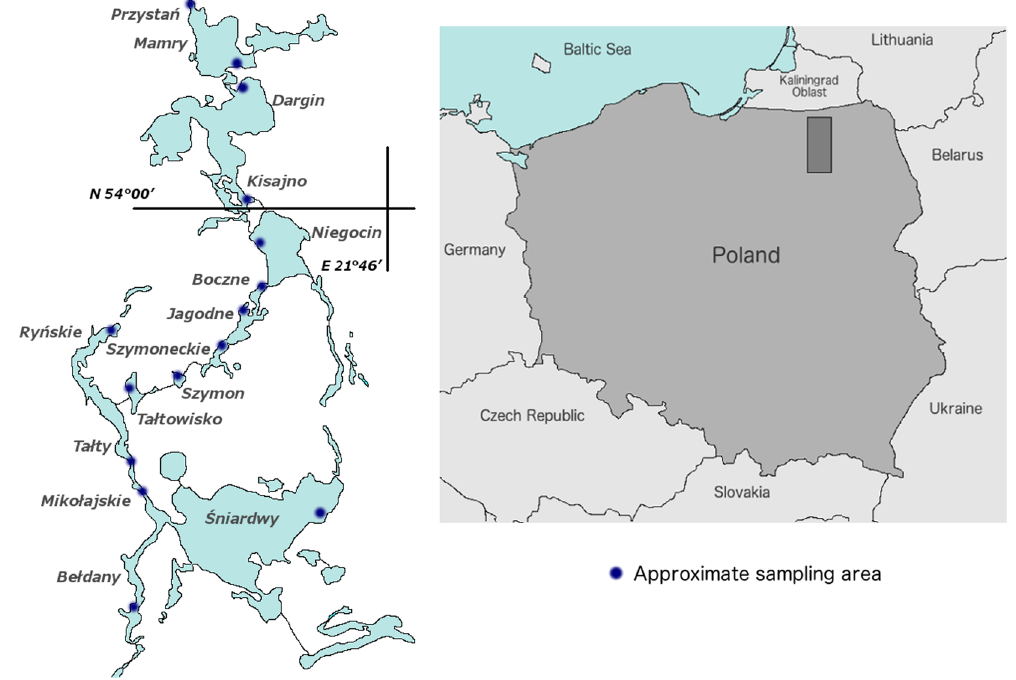
Figure 6. Locations of sampling sites within the Great Masurian Lakes System